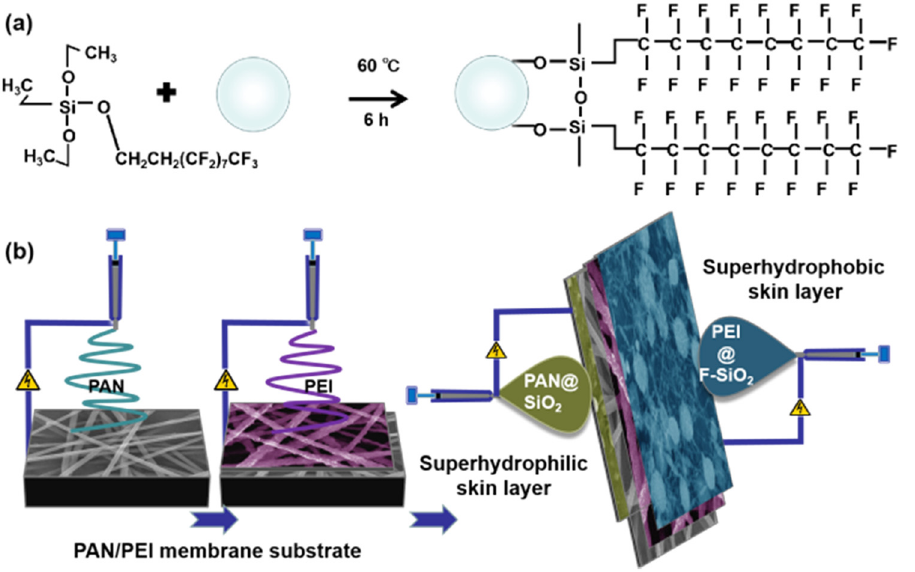
Figure 1: ( a ) Schematic diagram of the preparation of superhydrophobic SiO 2 NPs. ( b ) Schematic illustration of the fabrication of the PAN/PEI bilayer membranes and the asymmetric superwettability skin